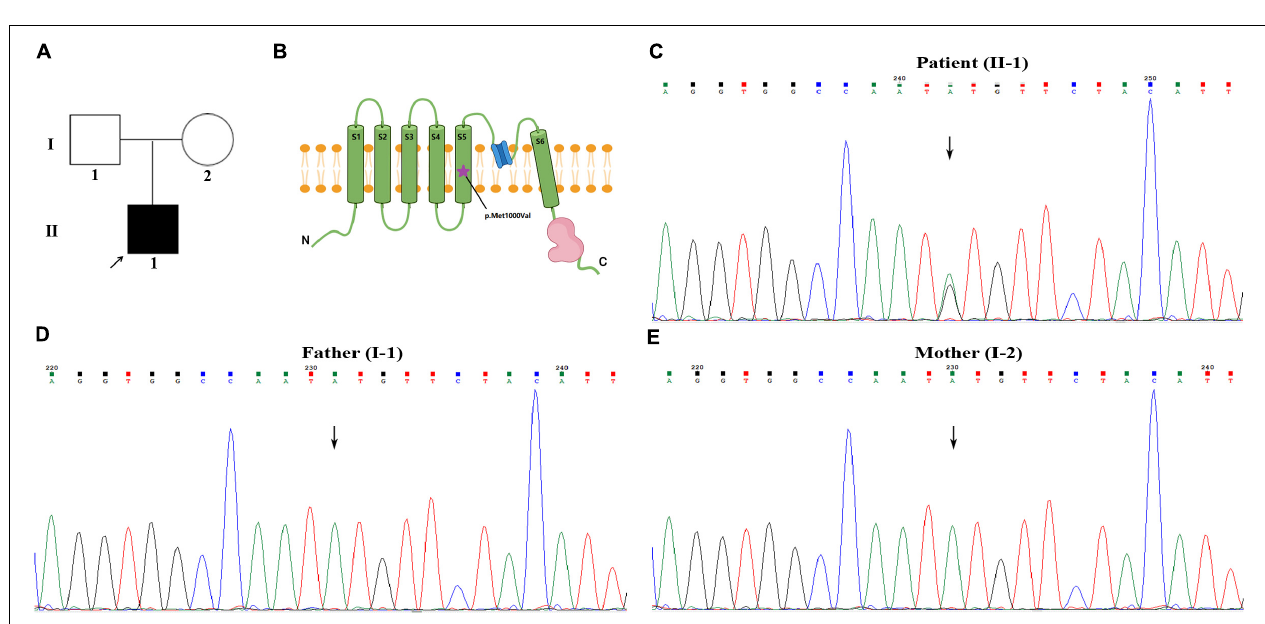
FIGURE 1 | No abnormalities in the patient’s brain MRI and magnetic resonance angiography (MRA). (A) Axial T1-weighted images (T1WI); (B) Axial T2-weighted images (T2WI); (C) Axial T2 fluid attenuated inversion recovery sequence images (Flair); (D) Diffusion-weighted imaging (DWI); (E) Magnetic resonance angiography (MRA) images.